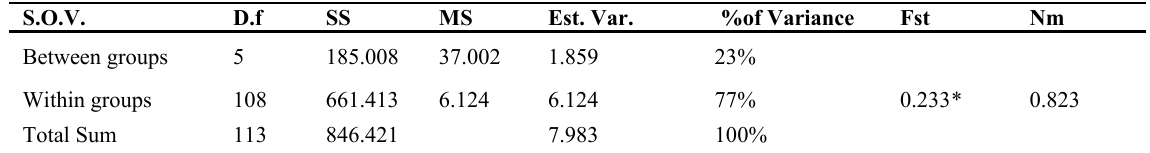
Table 3. Analyses of molecular variance (AMOVA) for six populations of Cygnus cignus). Statistics include sums of squared deviations (SS); mean squared deviations (MS), variance component estimates (Est. Var.), the percentage of the total variance contributed by each component.